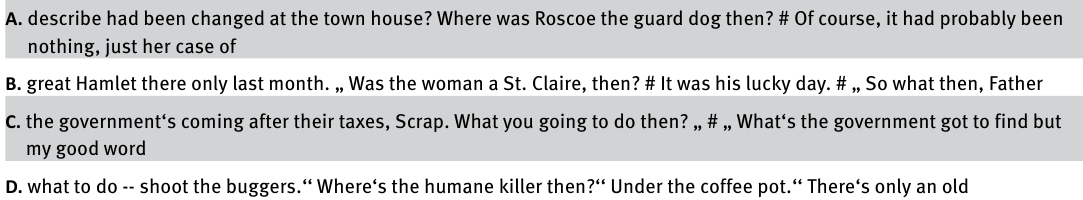
Table 2: Undecided cases of final